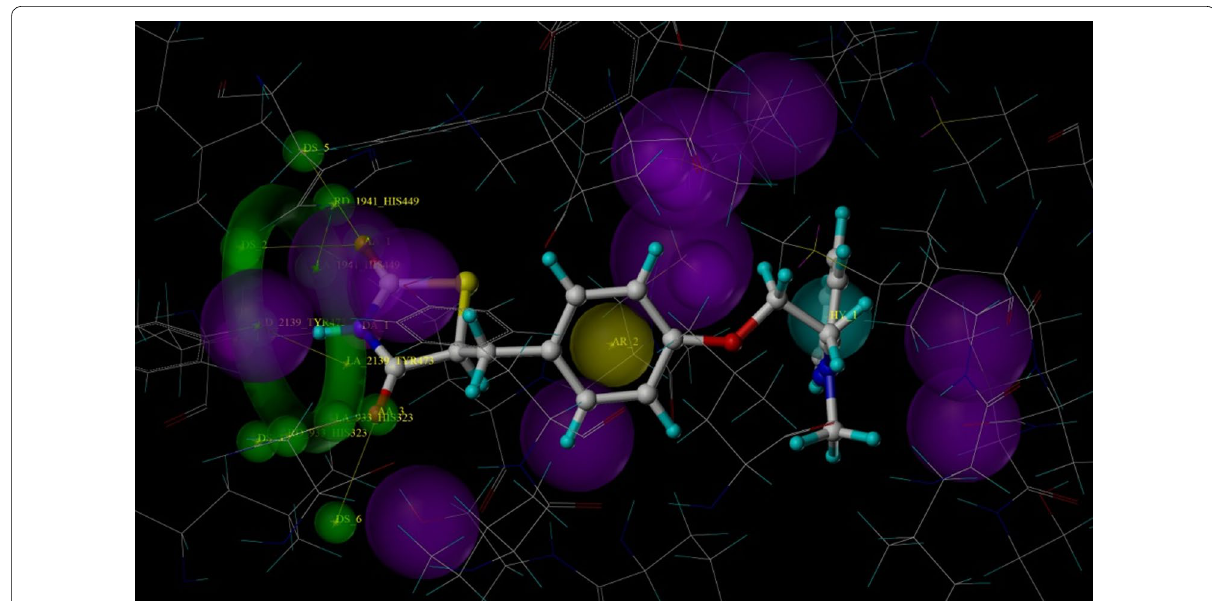
Fig. 3 Pharmacophoric QUERY built from protein ligand complex, where green representing hydrogen bond acceptor (0.5 Å tolerance), magenta representing hydrogen bond donor (0.5 Åtolerance) and also neighbouring amino acids (1.0 Å tolerance), yellow representing aromatic ring (1.0 Å tolerance) and cyan representing hydrophobic ring (1.0 Å tolerance)